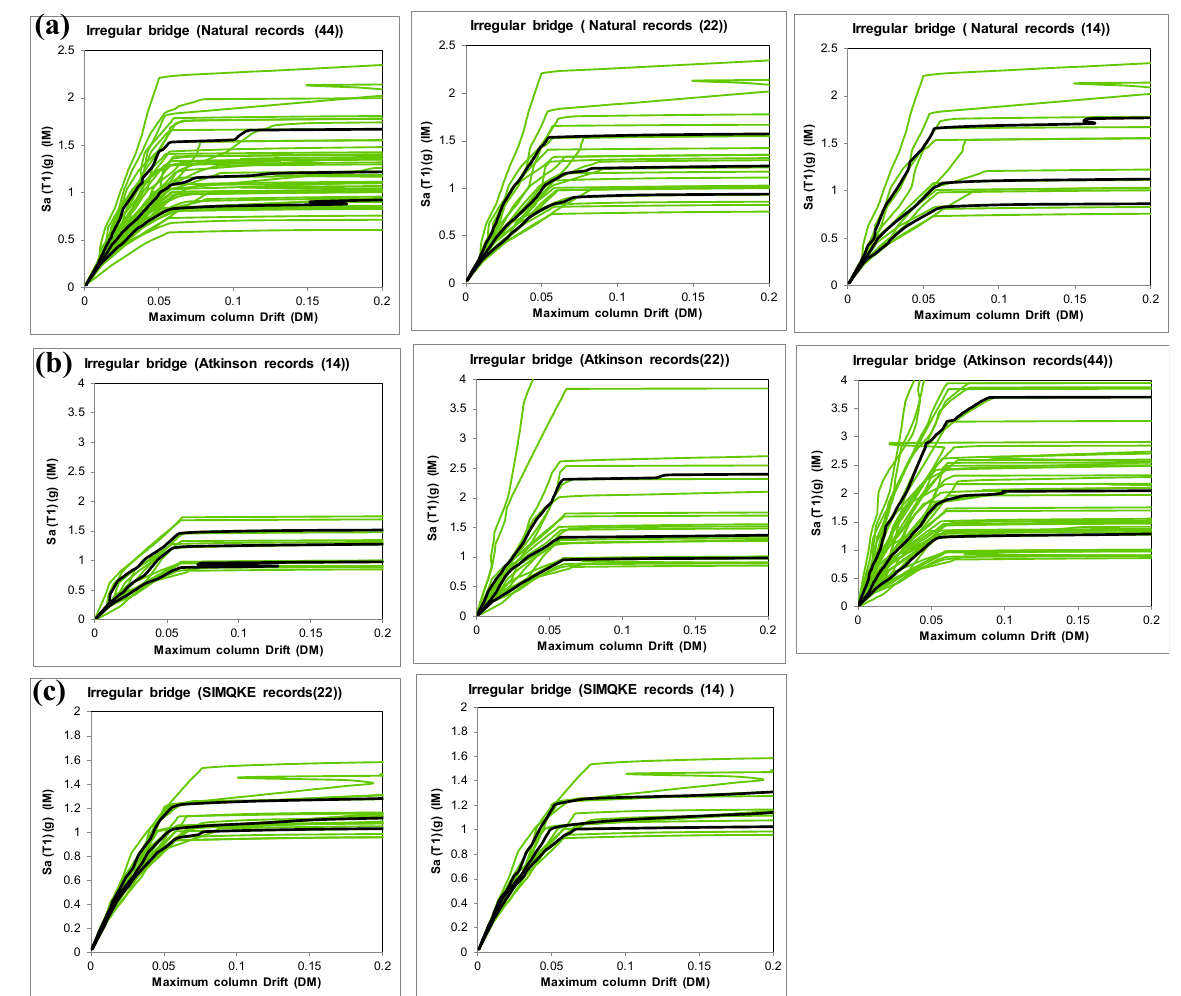
Figure 14. Effect of the number of records (indicated in parentheses) used on the IDA curves obtained for different record sets for the case of ( a ) natural records, ( b ) Atkinson records, and ( c ) SIMQKE records.